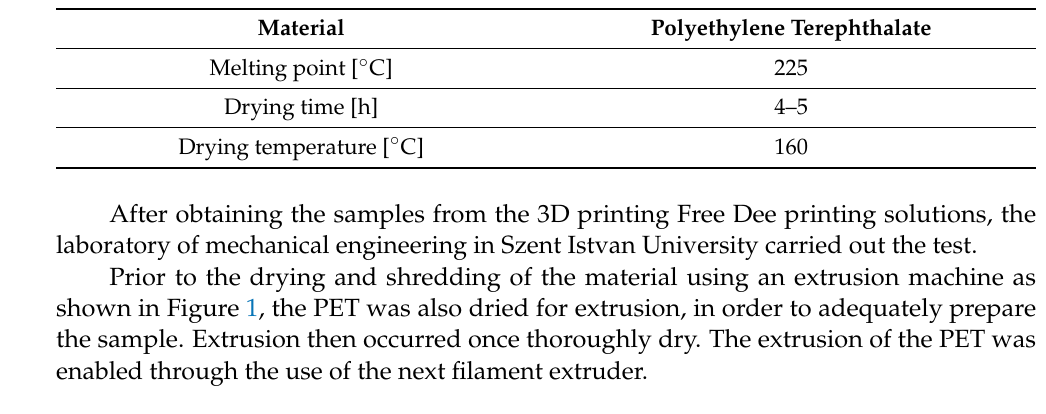
Table 1. Ratio and types of collected selective waste during the first trimester 2018.